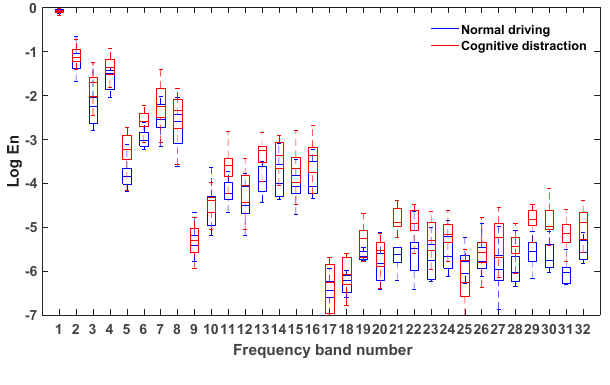
( A ) Box diagrams of the first 32 energies of frequency bands.